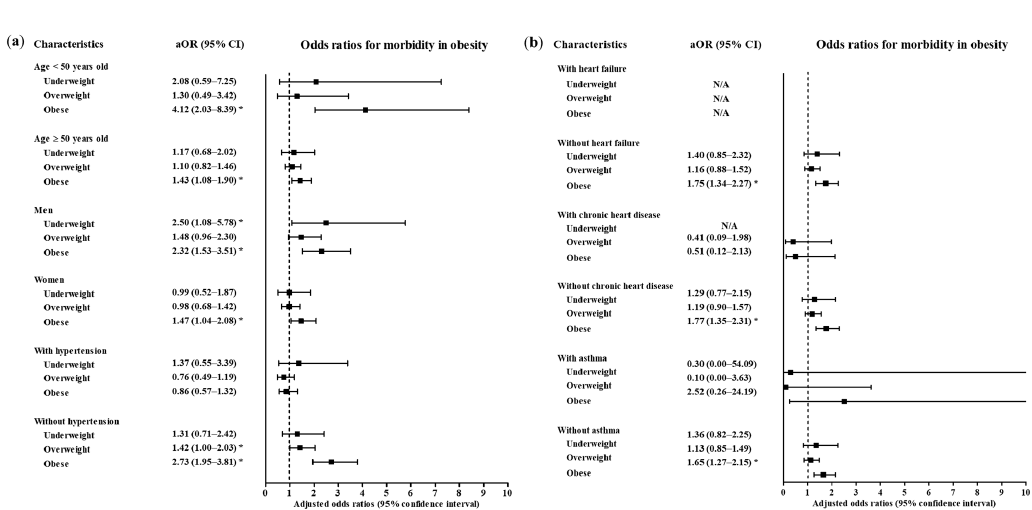
Figure 4. Subgroup analyses to obtain the adjusted odds ratios (95% confidence interval) for the maximum level of morbidity during hospitalization according to age, sex and hypertension ( a ) and heart failure, chronic heart disease and asthma ( b ). (* p < 0.05).